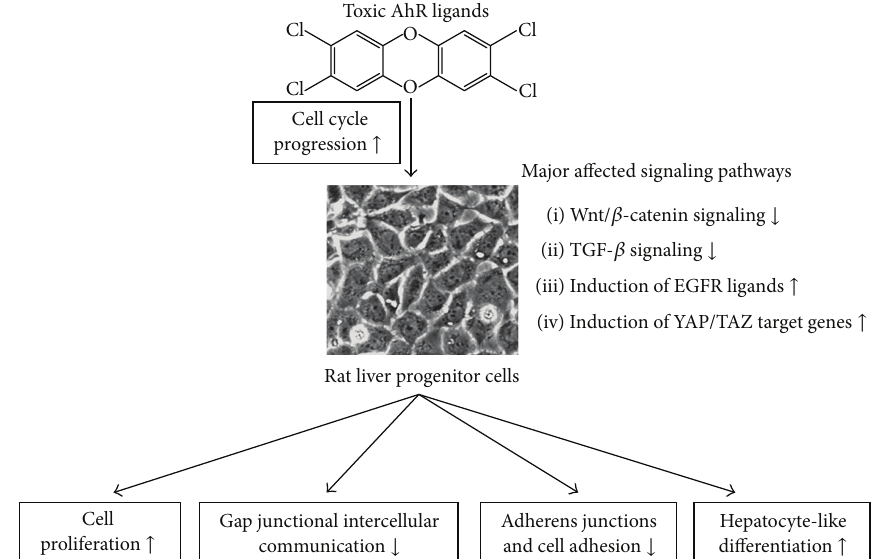
Figure 1: A summary of effects of AhR agonists on deregulation of signaling pathways and liver progenitor cell functions in WB-F344 cell